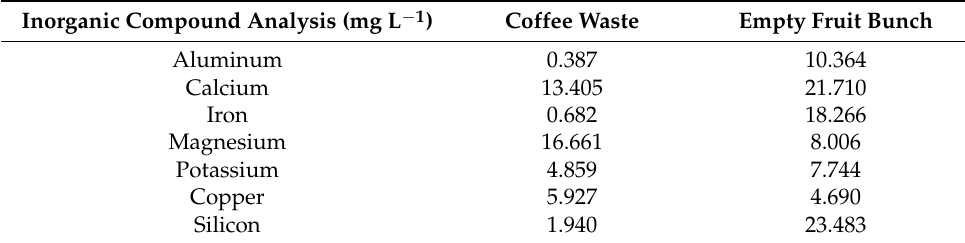
Table 2. Determination of the inorganic content of coffee waste and empty fruit